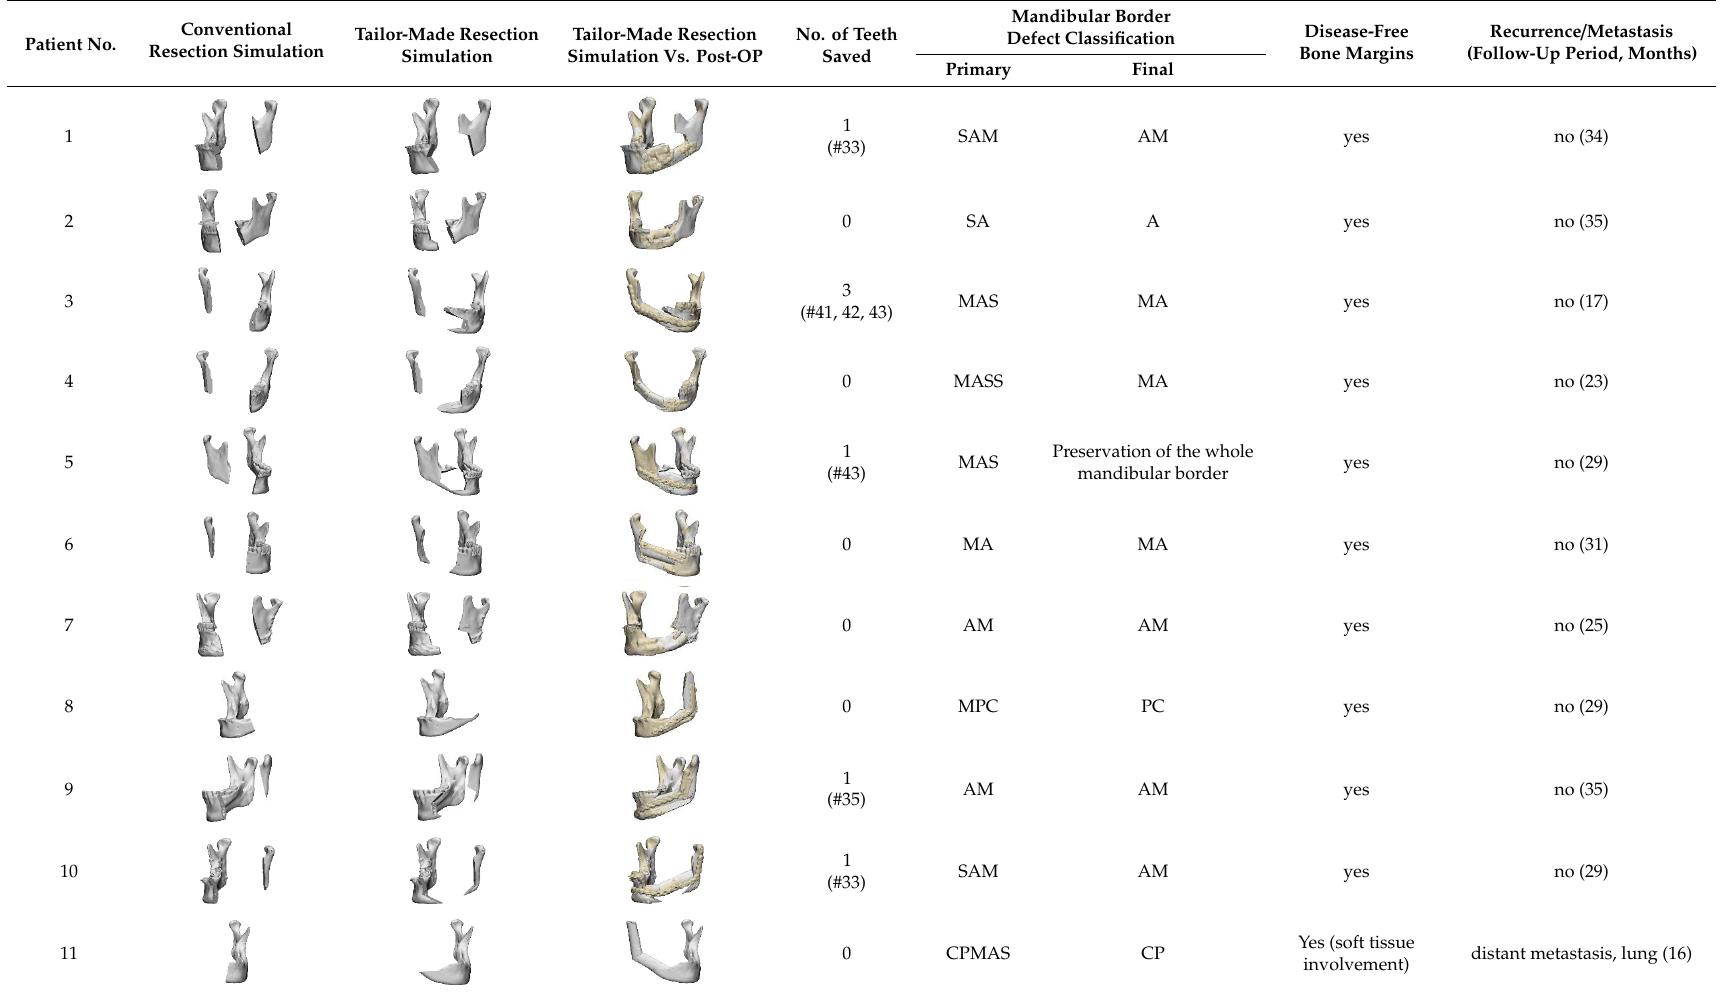
Table 2. Clinical patients’ outcomes. Table 2. Clinical patients ’ outcomes. Table 2. Clinical patients ’ outcomes. Table 2. Clinical patients ’ outcomes. Table 2. Clinical patients ’ outcomes. Table 2. Clinical patients ’ outcomes. Table 2. Clinical patients ’ outcomes. Table 2. Clinical patients ’ outcomes. Table 2. Clinical patients ’ outcomes. Table 2. Clinical patients ’ outcomes. Table 2. Clinical patients ’ outcomes. Table 2. Clinical patients ’ outcomes. Table 2. Clinical patients ’